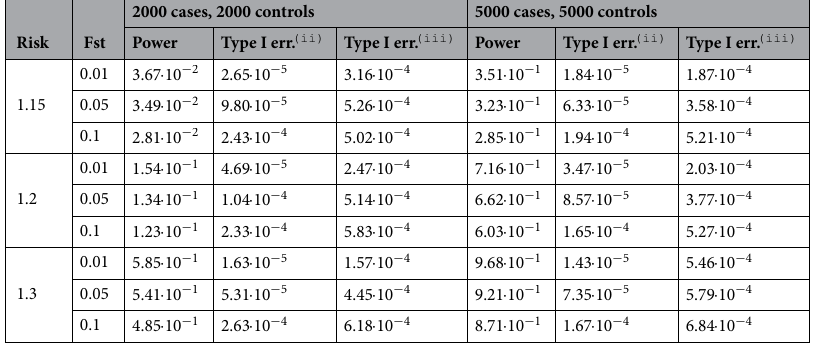
Table 3. Performance of cc-GWAS as implemented in ReACt with different sample sizes. Three types of SNPs have been simulated: (i) trait differential SNPs; (ii) null SNPs; and (iii) stress SNPs. . Under each condition, we simulated individual level genotype with these three types of SNPs for N cases and N controls in each study 2000 and N 5000 ) and generated GWAS summary statistics for each study. and generated GWAS ( N = = summary statistics for each study respectively. We subsequently used the summary statistics to run cc-GWAS in ReACt. We reported the power for detecting type (i) SNPs, and false positive rates for picking up type (ii) (ii) (iii) 5 10 SNPs (Type I err. ) and type (iii) SNPs (Type I err. ) under a significance threshold p < 5 − ·